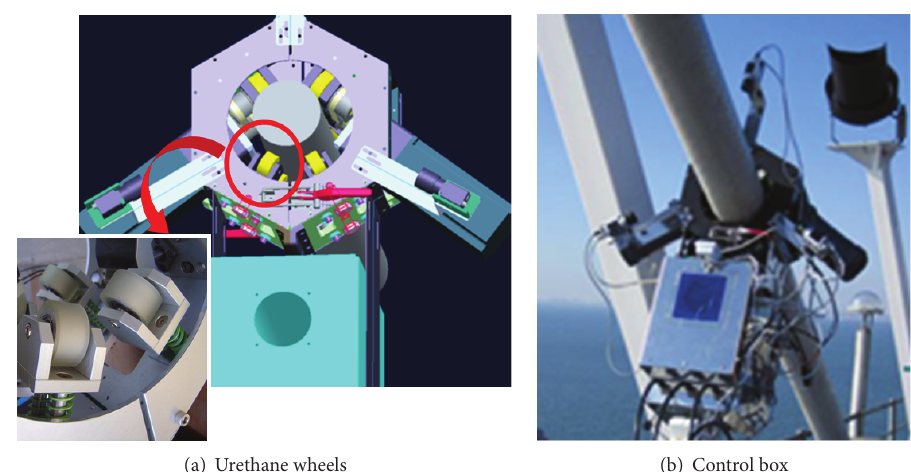
Figure 19: The cable climbing robot for stay cables in cable-stayed bridges.